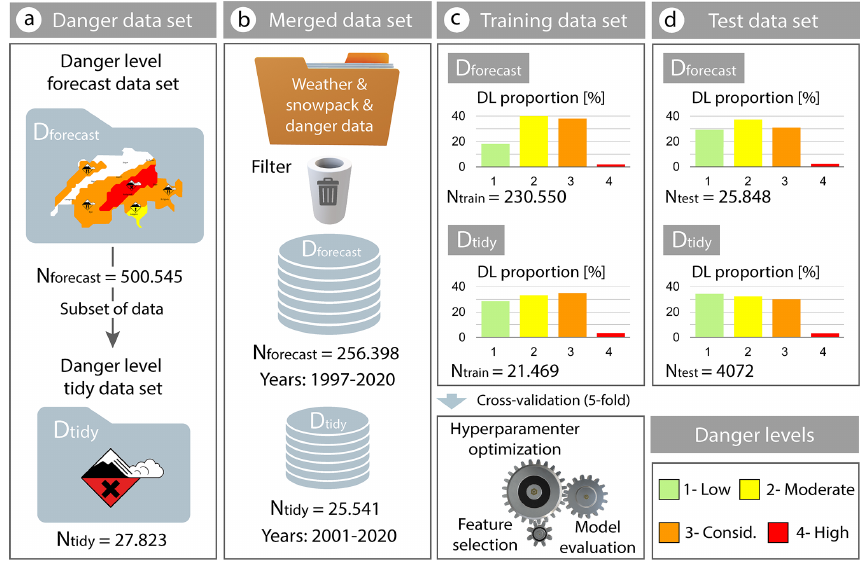
Figure 3. Flowchart of the data set distributions and steps, including the raw data volume, the merged and filtered data set size, and the danger level distributions of the training and test sets. Two machine learning classifiers are trained using as labels (i) the forecast danger levels ( D forecast ) in the public bulletin and (ii) a subset of tidy danger levels ( D tidy ). An iterative process of hyperparameter tuning and feature selection using 5-fold cross-validation was conducted to select the best